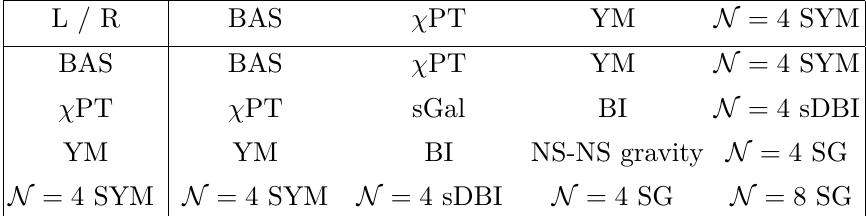
Table 1 . The table shows the tree-level double-copy L ⊗ R for a selection of different choices of L and R single-color models. BAS is the cubic bi-adjoint scalar model which is described more in